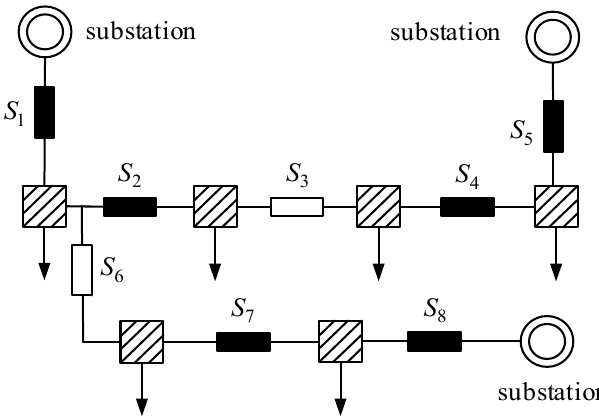
Figure 9. Topology structure of 10 kV feeder layer.